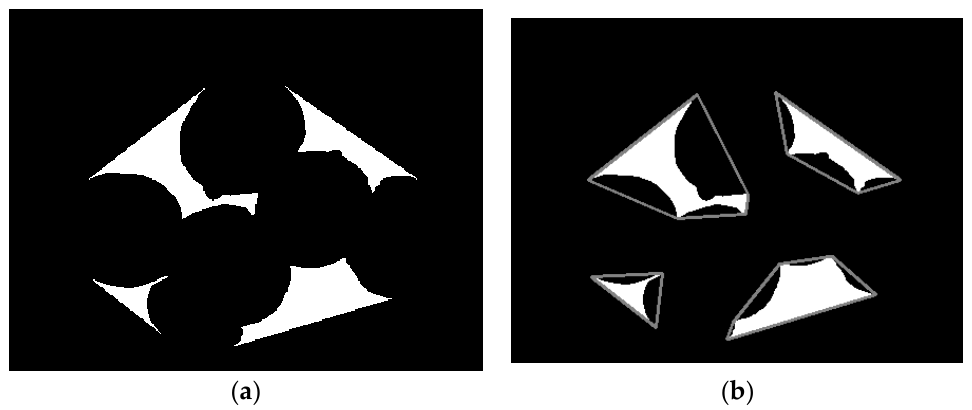
Figure 6. Extraction and simplification of concave areas. ( a ) Concave area; ( b ) polygon simplification.